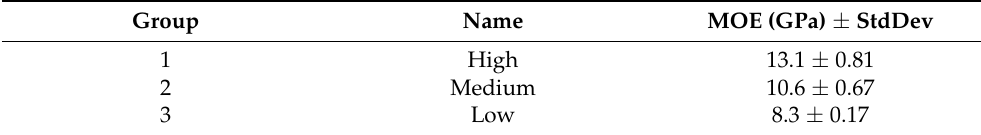
Table 2. Test results of the average MOE for E. nitens